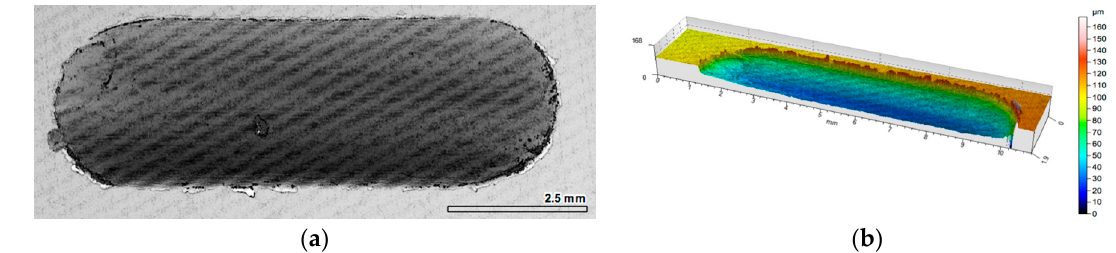
Figure 6. View of wear track in AlSi12/Al 2 O 3 _1 composite layer (P1) after dry sliding condition: ( a ) digital image; ( b ) cross-section through 3D view.